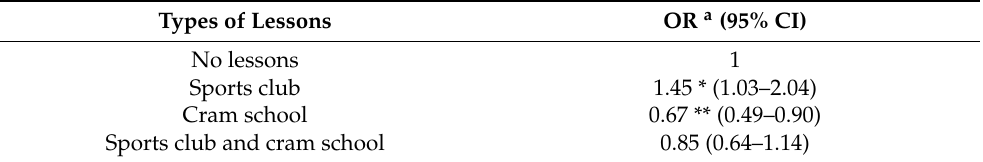
Table 3. Results of logistic regression